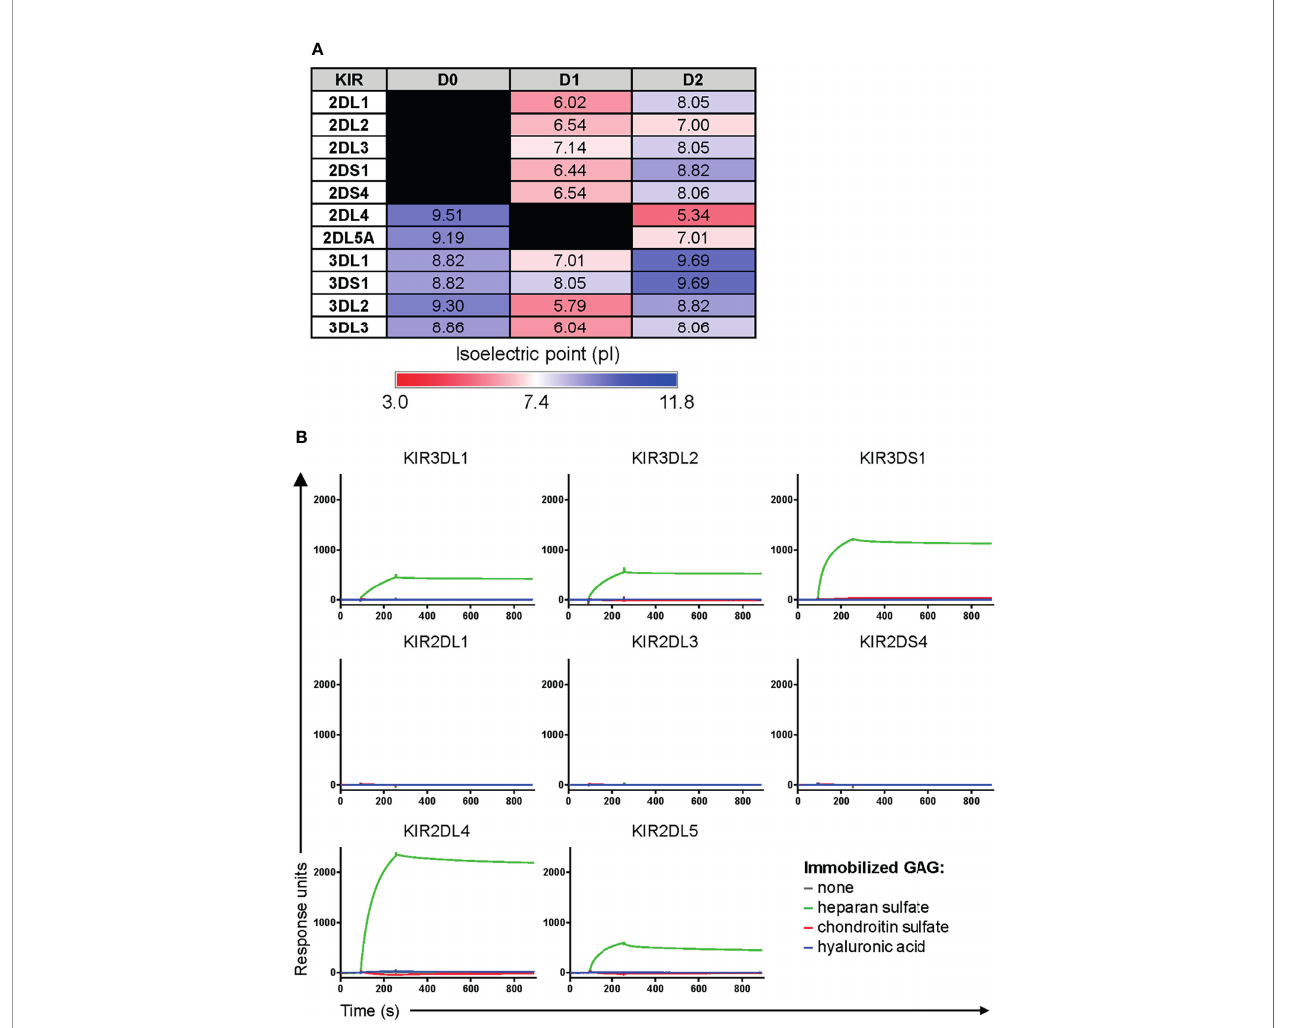
FIGURE 2 | KIRs that contain a D0 domain bind heparan sulfate. (A) The isoelectric point (pI) of individual domains and regions of the indicated KIRs was calculated using the ExPASy Compute pI/Mw tool (24). This was used as a rough estimate of the net charge status of each domain/region. (B) Surface plasmon resonance sensograms of Fc constructs of the indicated KIRs (at 25 m g/mL) fl owed over immobilized heparan sulfate, chondroitin sulfate, or hyaluronic acid for 3 min, and then allowed to dissociate by fl owing over buffer for 10